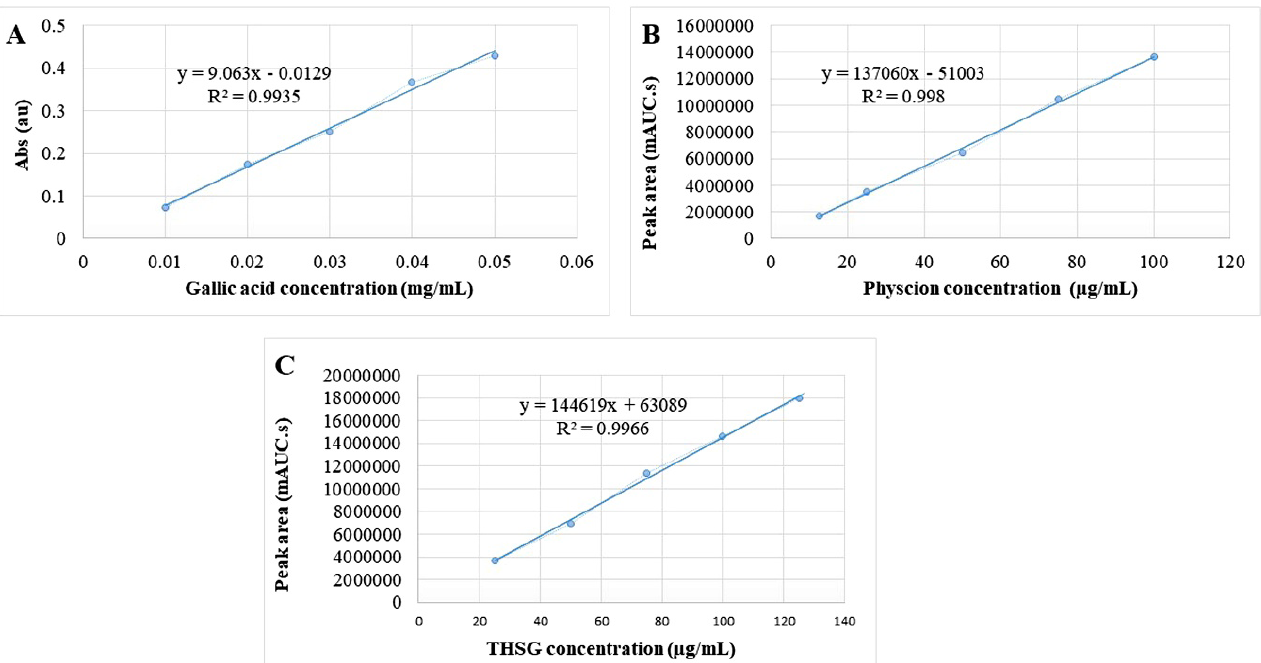
FIGURE 3 - The calibration curve of gallic acid (A), physcion (B), THSG